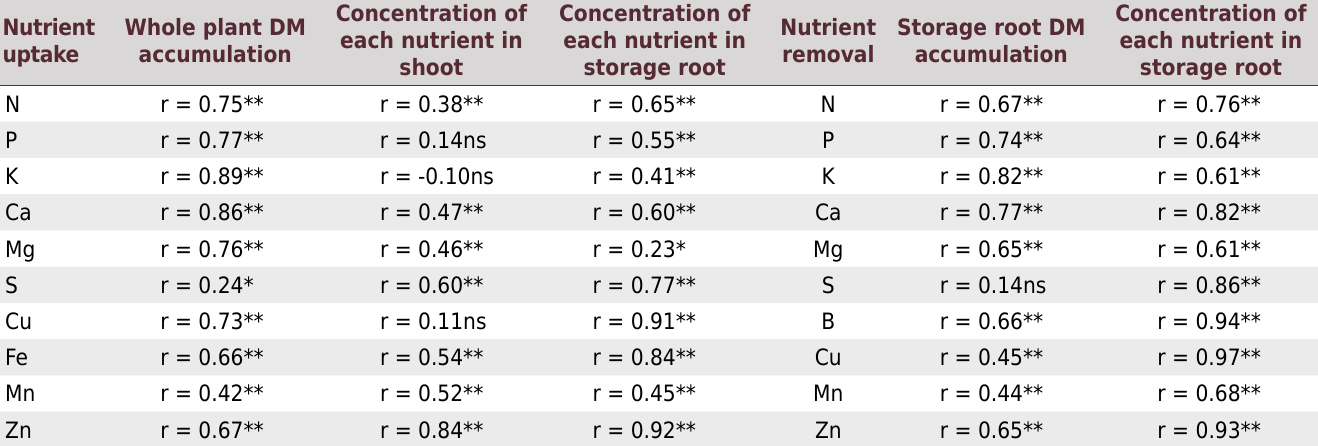
Table 7. Correlations of whole plant dry matter (DM) accumulation and nutrient concentrations in shoot and storage root with total nutrient uptake and correlations of DM accumulation and nutrient concentrations in storage root with nutrient removal by sweet